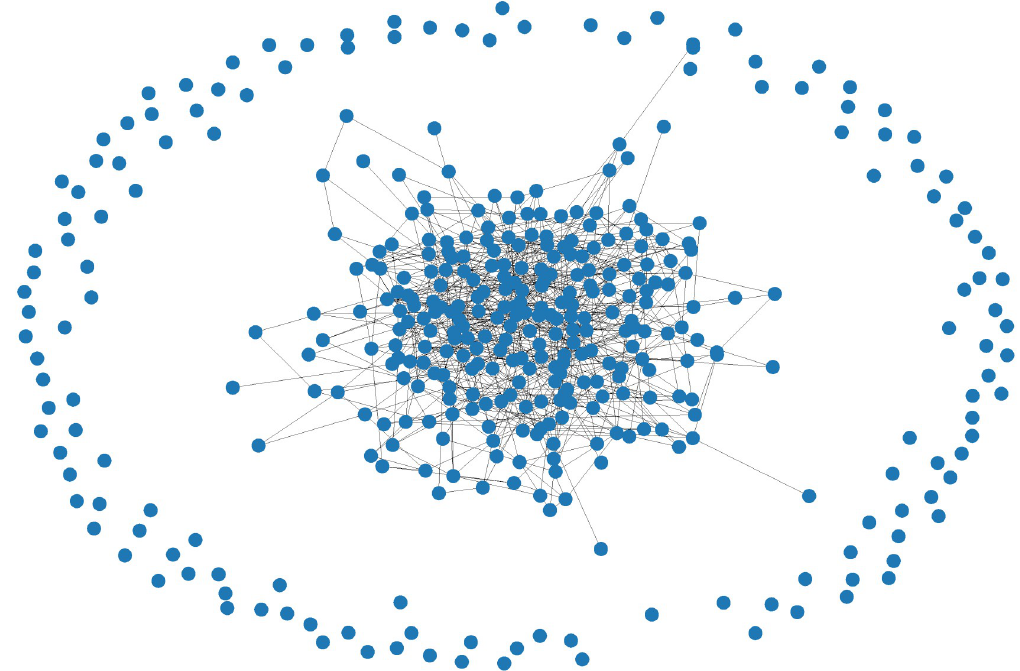
Fig 10. Illustration of core-periphery structure as a result of reconnecting with fitness-proportional probability. The central cluster has a degree distribution identical to that of a random network.